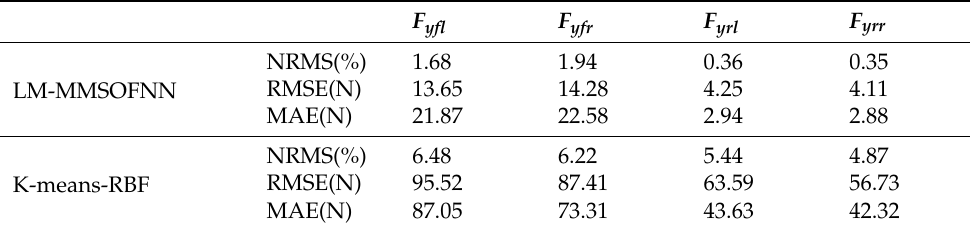
Table 9. Lateral tire force estimation errors of LM-MMSOFNN and K-means-RBF.